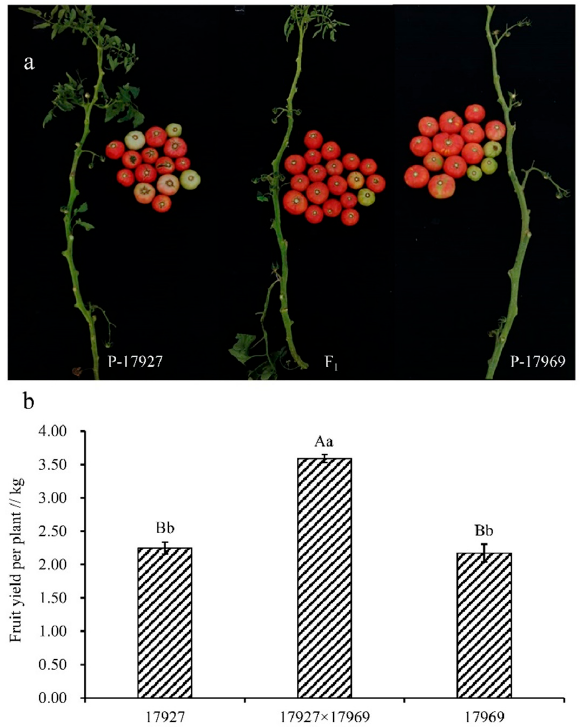
Figure 5. Phenotypes of cross 17,927 × 17,969 and its parents. ( a ) Representative plants and corre- sponding fruit yield from each of the three genotypes. ( b ) Single plant yield data from a randomized block experiment of each of the three genotypes are shown. Single plant yield (kg) is represented on the y-axis. The yields of the three genotypes were compared using a multiple-comparison Tukey test. Uppercase and lowercase letters indicate differences at the 0.01 and 0.05 levels, respectively.